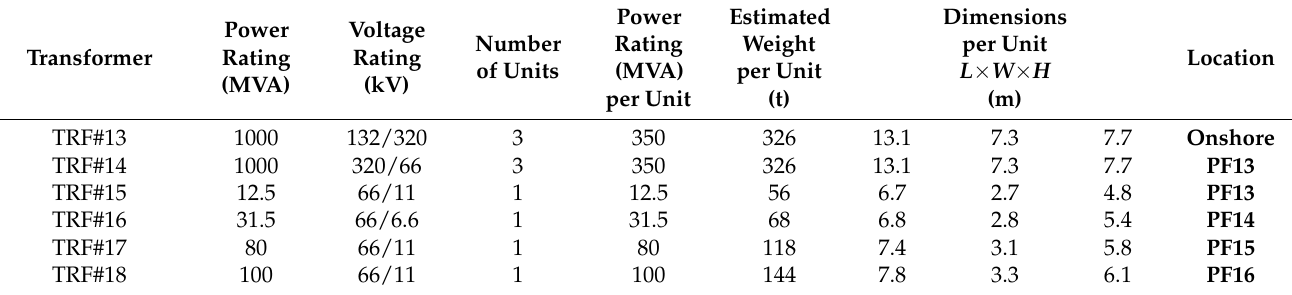
Table A11. Transformers design for Architecture 4.